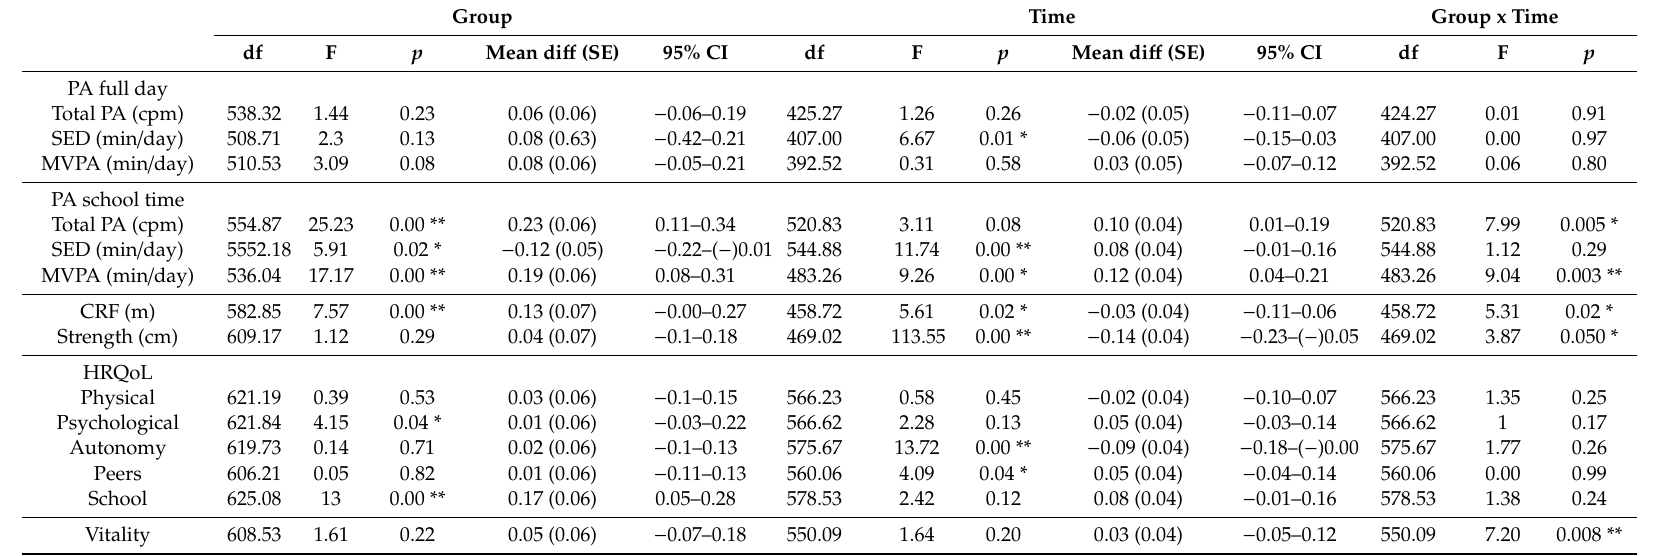
Table 4. E ff ects for the whole